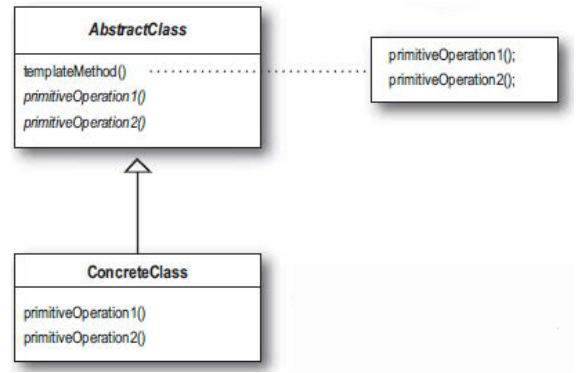
Fig. 5. Template Pattern UML diagram